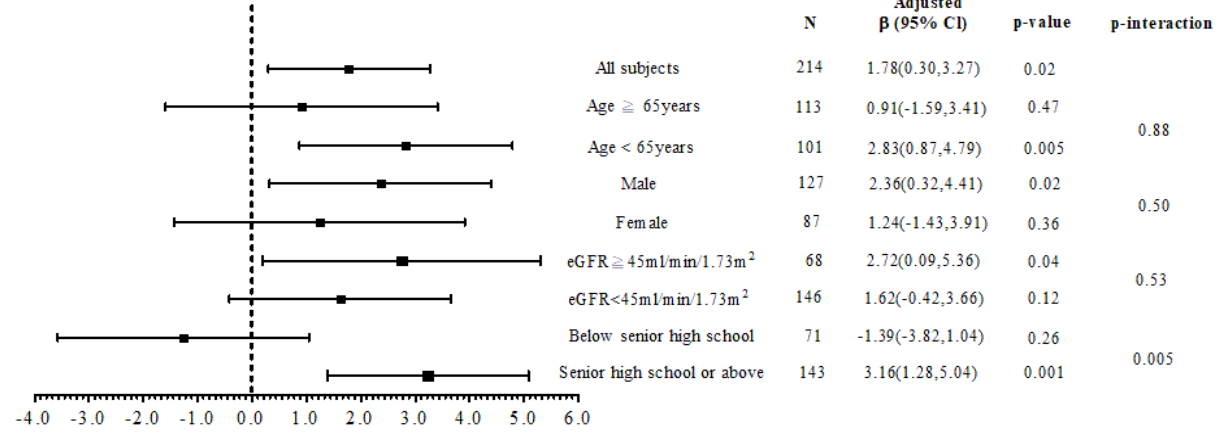
Figure 3. The association between mHealth usage and disease knowledge in subgroup analysis.